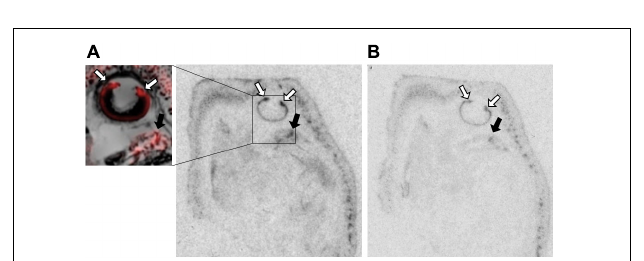
FIGURE 3 | OXTR ligand binding in the ciliary bodies of the eye of neonatal prairie voles. (A) Pseudo-color composites (OXTR in red, cresyl violet counterstain in gray) of neonatal prairie vole with 0 nM OXT competition. White arrows indicate ciliary bodies; quantifications were measured at the ciliary bodies only; no measures were taken from the posterior retina. Black arrows indicate brain tissue. (B) 1000 nM unlabeled OXT competes off ligand binding in both the ciliary body and the brain.